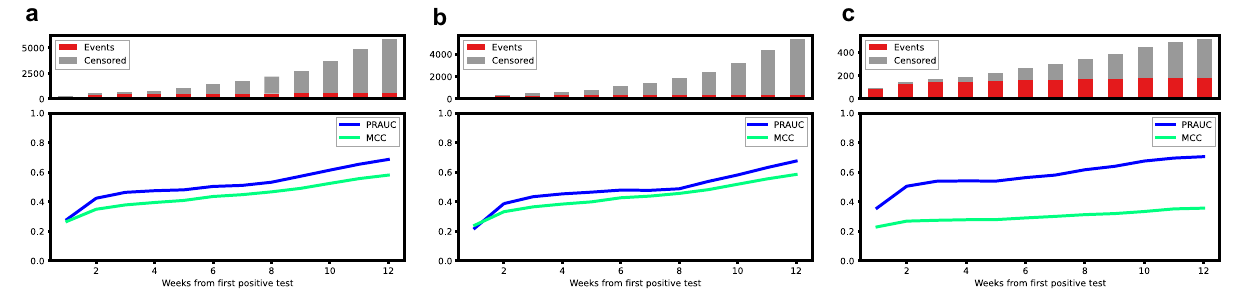
Figure 2. Binary performance metrics for 12 weeks mortality prediction. Precision-recall area under the curve (PR-AUC) and Mathews correlation coefficient (MCC) were calculated for each predicted week only considering non-censored patients in the test set. The lower panel of each plot depicts the mean values of PR-AUC and MCC at each week based on all patients ( a ), patients not admitted to the hospital at the time of first positive test ( b ) and patients who were admitted at the time of first positive test ( c ). The upper panels of each subfigure contain bar plots showing the number of patients who died (red) during the given week while patients censored due to lack of follow-up (grey) were omitted for the performance metrics.